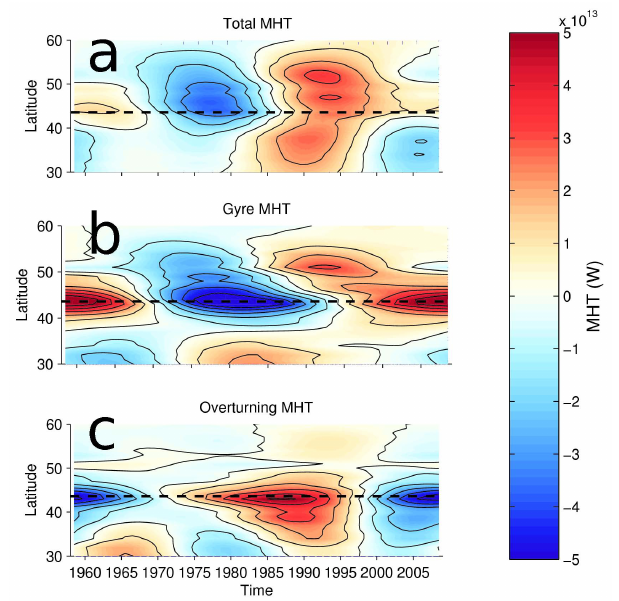
Fig. 5. Hovm¨oller diagrams of anomalous total (a) , gyre (b) and overturning (c) MHT (watts) against latitude. The mean latitude of the SPF in the NFB (44 ◦ N) is shown with a dashed line in all the panels. Red indicates northward heat transport, blue southwards. A colour bar shows the magnitude of the MHT anomalies.